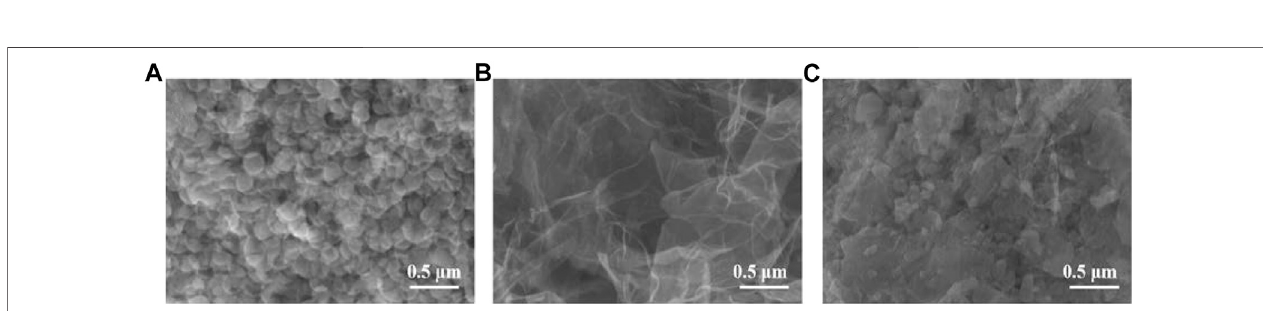
FIGURE 2 | SEM images of (A) AgNPs (B) MoS 2 /rGO, and (C) AgNPs/MoS 2 /rGO.